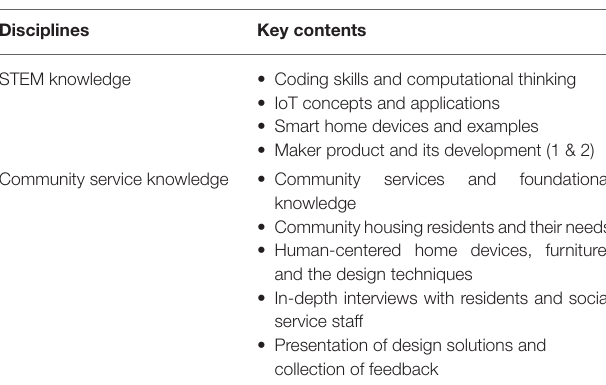
TABLE 1 | Contents in the integrated STEM-based community service-learning